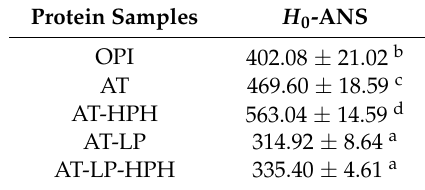
Table 2. H 0 of OPI and the modified samples in 0.01 M phosphate buffer (pH 7.0).